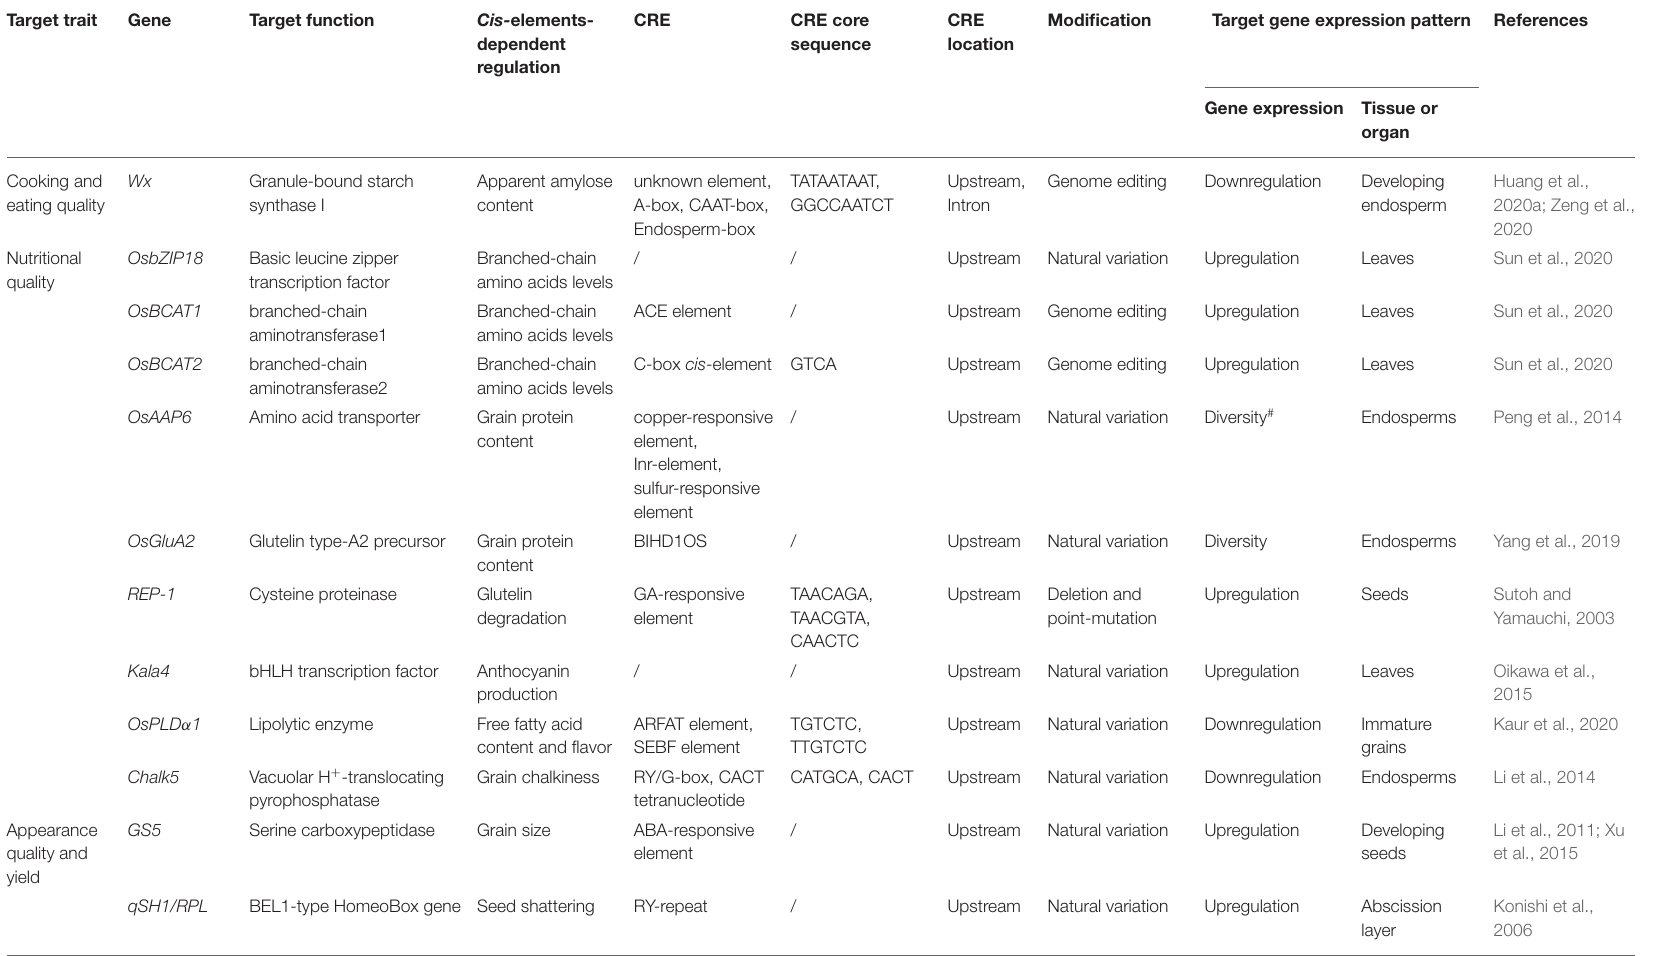
TABLE 1 | Improvement in rice quality achieved via the modification of cis -regulatory